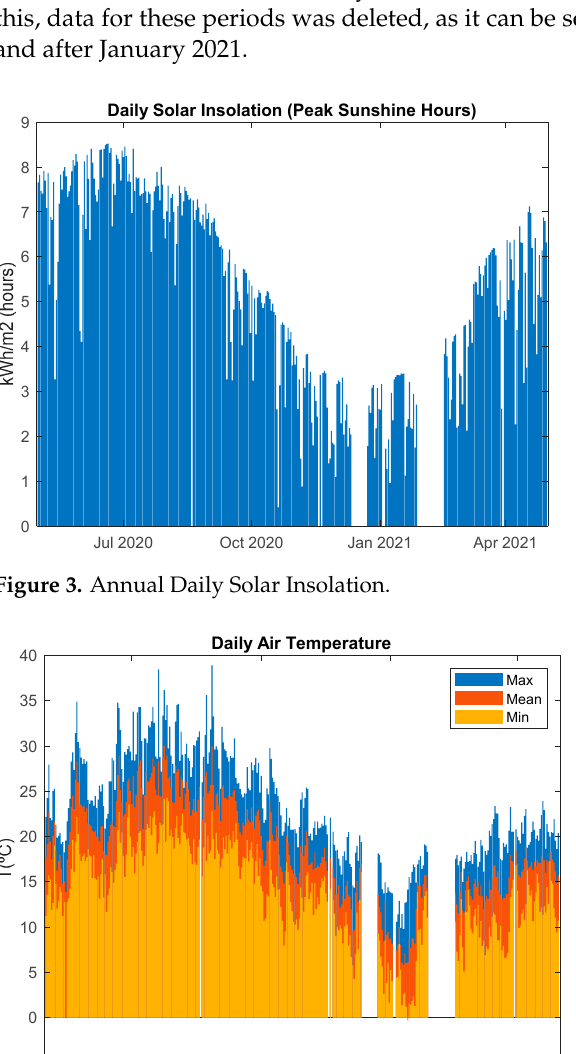
Figure 6. Annual home energy consumption. During the yearly period, approximately 10 MWh were consumed in the residence. The following two figures show the power injected into the grid (Figure 7) and bought from the grid (Figure 8). As can be seen, the house is a nearly zero annual energy building but unfortunately, due to the tariffs, that is not translated into economic costs. As it can be seen, except in the winter period, a large amount of energy was supplied to the grid.